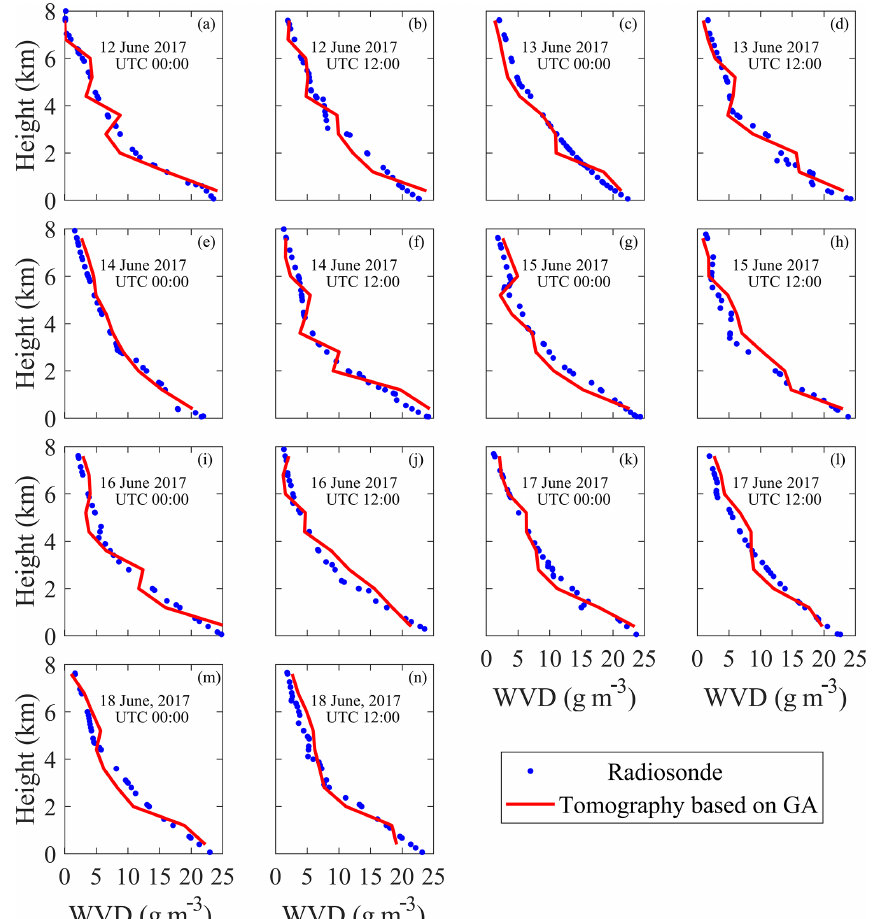
Figure 9. Panels (a) – (n) represent water vapour density comparisons between radiosonde and tomography based on the genetic algorithm at 00:00 and 12:00UTC from 12 to 18 June 2017 (rainy